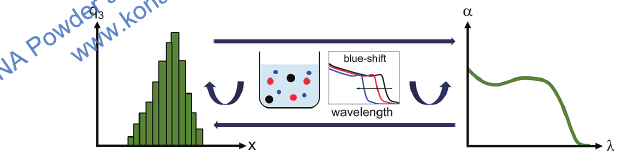
Fig. 3 Sketch of the correlation between polydispersity in par- ticle size and absorbance that is finally accessible by UV/Vis/NIR analysis (Segets D. and Peukert W., 2014).